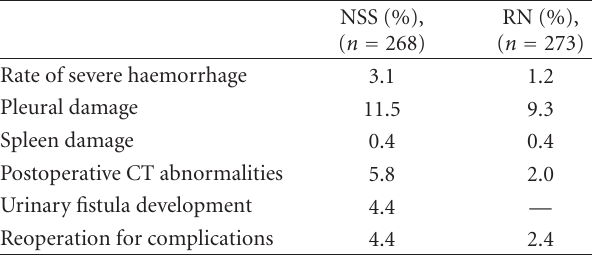
Figure 1: Techniques used in open NSS. NSS: Nephron sparing sur- gery. Table 2: Complications of open NSS and RN